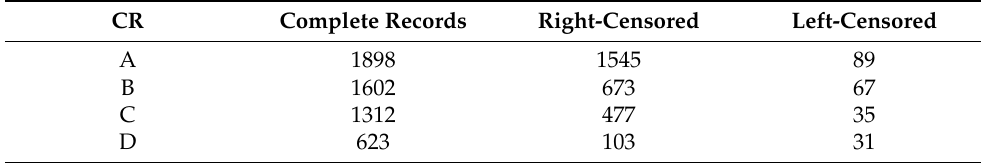
Table 4. Grouping of main girder inspection records by data completeness.